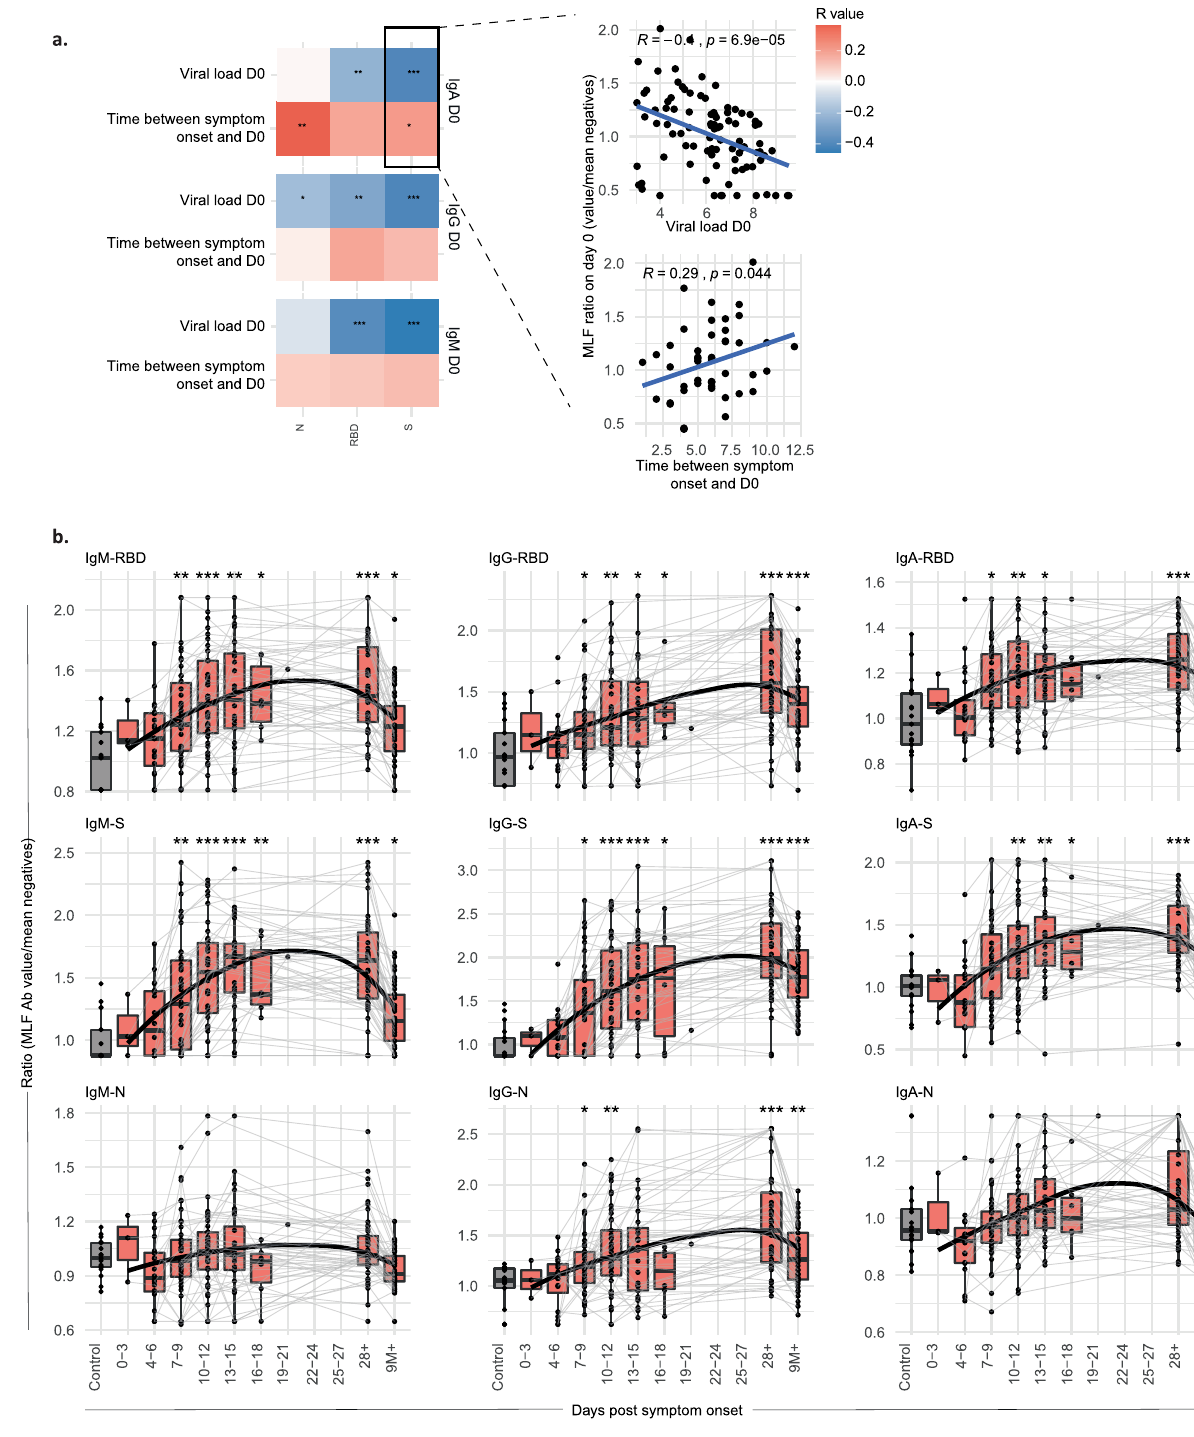
Fig. 3 Mucosal antibody responses are correlated with viral load and persist up to nine months after symptom onset. a IgM, IgG and IgA antibody responses against SARS-CoV-2 spike (S), receptor-binding domain (RBD) or nucleocapsid (N) collected in mucosal lining fl uid at study start were correlated with viral load at study start and time between symptom onset and study start. Two-sided Spearman correlations were calculated, * P < 0.05, ** P < 0.01, *** P < 0.001. The correlation plots of IgA-S are shown as an example, all correlation plots can be found in Supplementary Fig. S4, together with the exact P values of the correlations. b Longitudinal mucosal antibody responses to S, RBD and N, plotted as a ratio to mean of the pre-pandemic negative controls ( n = 17, grey boxplots), relative to the days post symptom onset. The boxplots display a median line, interquartile range (IQR) boxes, 1.5*IQR whiskers and individual data points. Values within each timeframe were compared with the controls with the two-sided Wilcoxon signed-rank test. A non- parametric Loess curve is shown to visualise the trend over time. Measurements from the same individual are connected with a grey line. Source data are provided as a Source Data fi